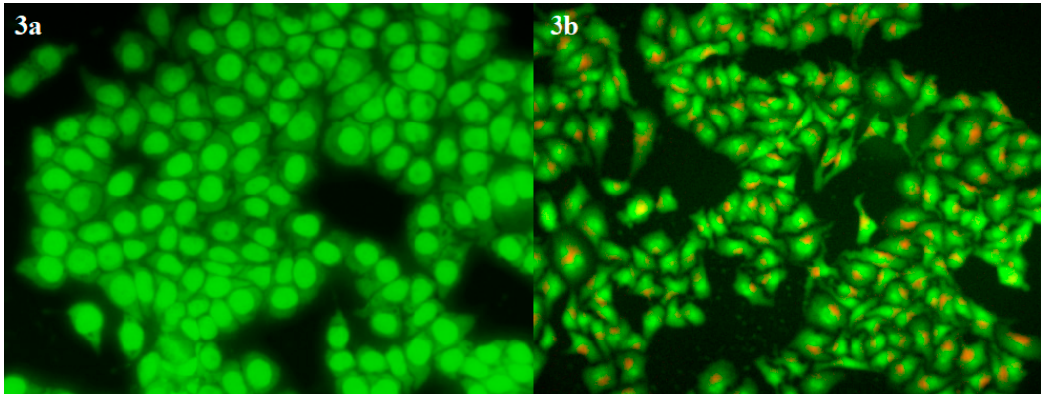
Figure 3. The cell morphology of HepG2 cells of the control and test groups. ( a ) HepG2 cells treated without any compounds; ( b ) HepG2 cells were treated with 0.01 µM for 12 h; Changes of nuclear morphology were determined by AO staining.